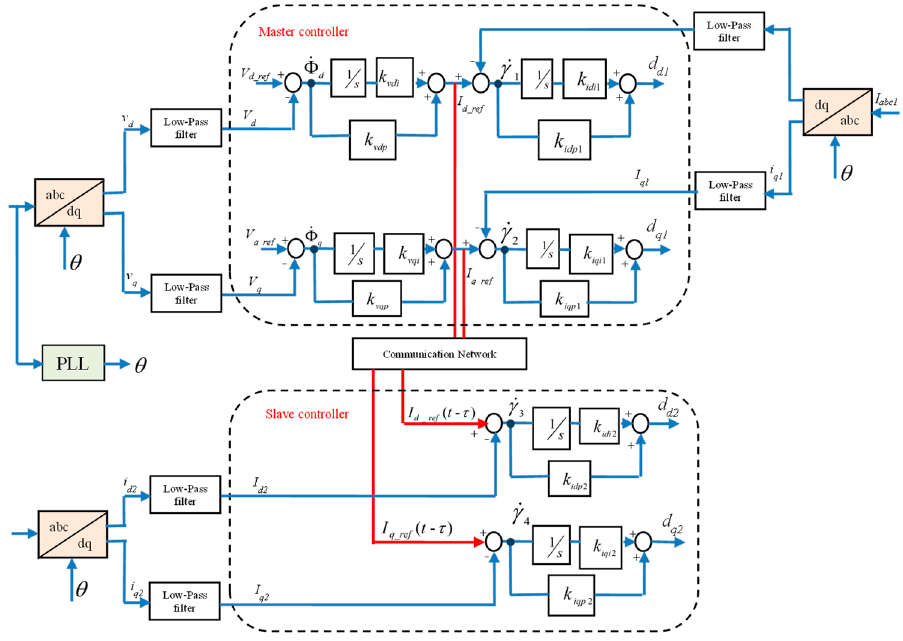
Figure 3. The controller of the master and the slave inverters.